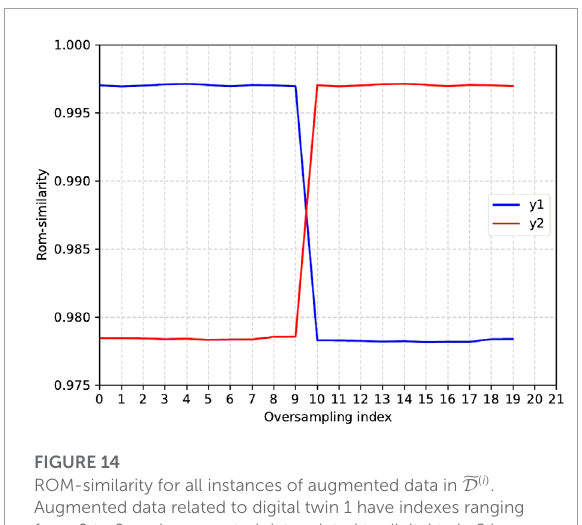
FIGURE 14 ROM-similarity for all instances of augmented data in ̃ D ( i ) . Augmented data related to digital twin 1 have indexes ranging from 0 to 9, and augmented data related to digital twin 2 have indexes ranging from 10 to